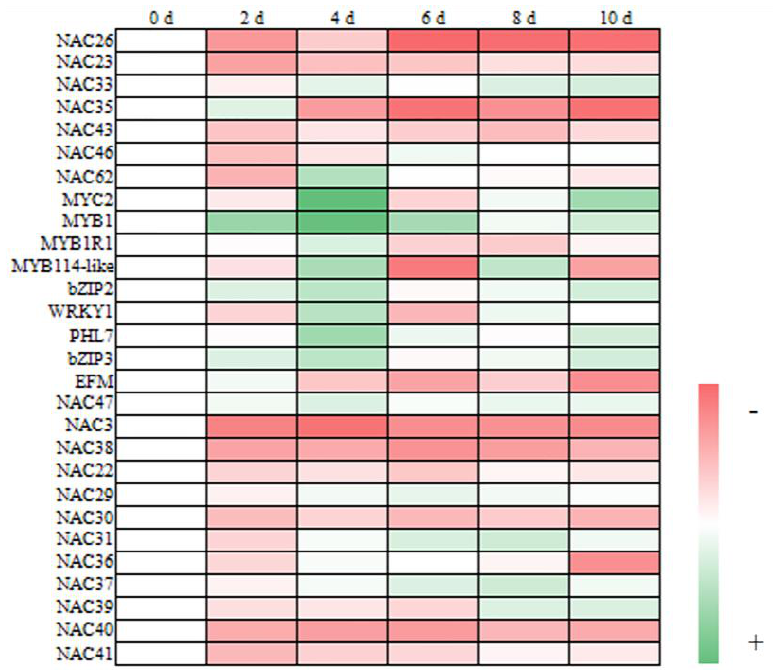
Figure 12. Heatmap analysis of the expression of 28 transcription factors in blueberry fruit. By analyzing these 28 transcription factors, we obtained 12 transcription factors with significant differences, as shown in Figure 13.